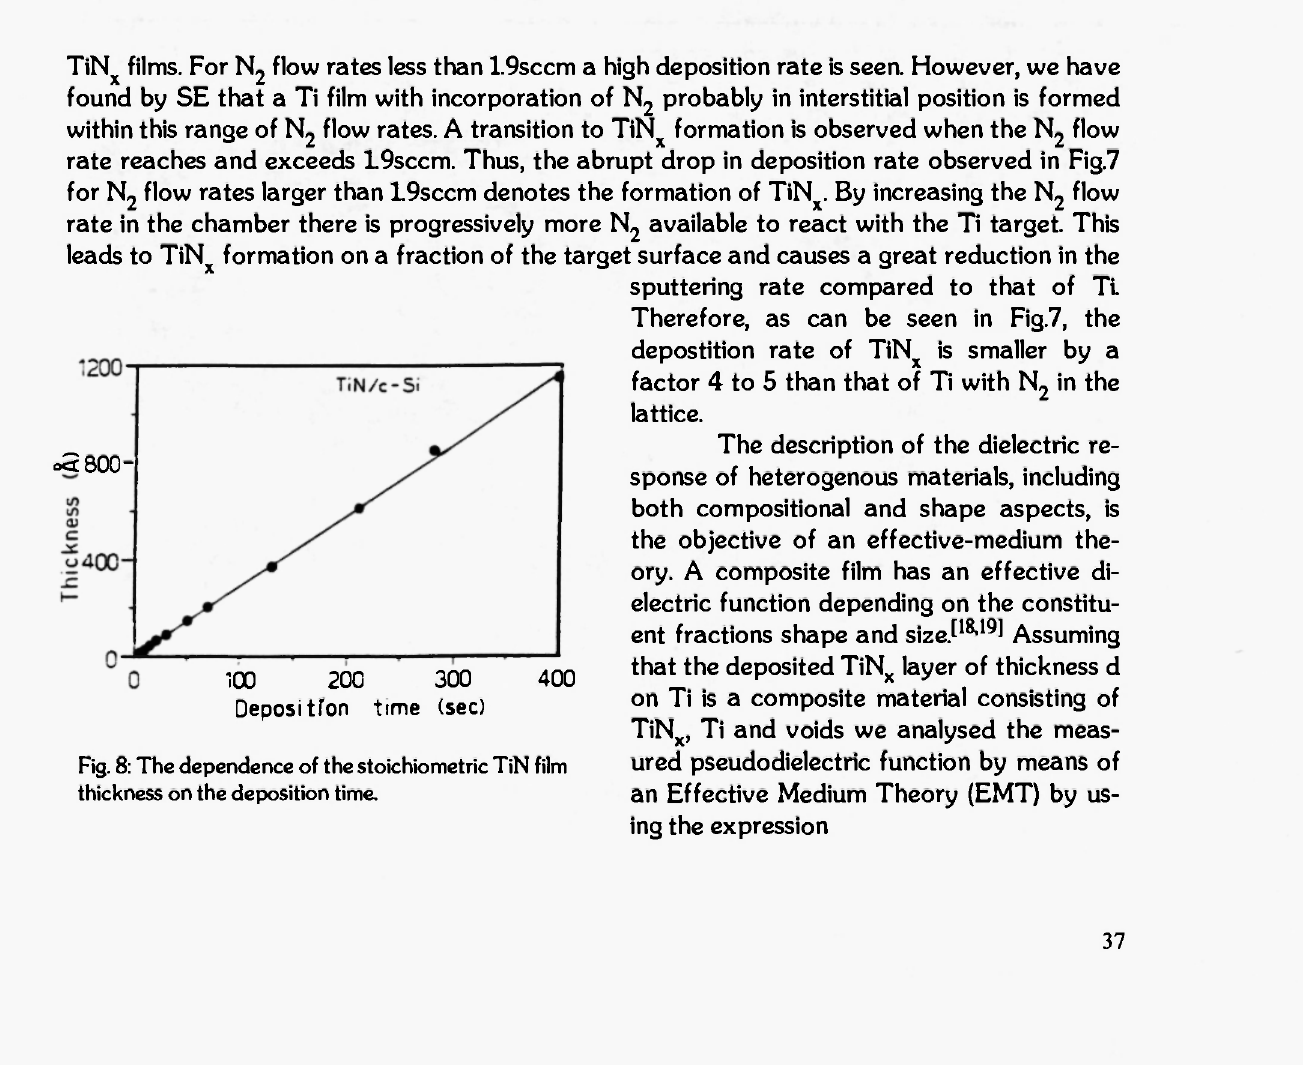
Fig. 6: The dependence of ω ρ and stoichoimetry on Fig. 7: The effect of N 2 flow rate on the deposition rate N 2 flow rate during TiN x deposition with -120V bias. and TiN x stoichiometry.